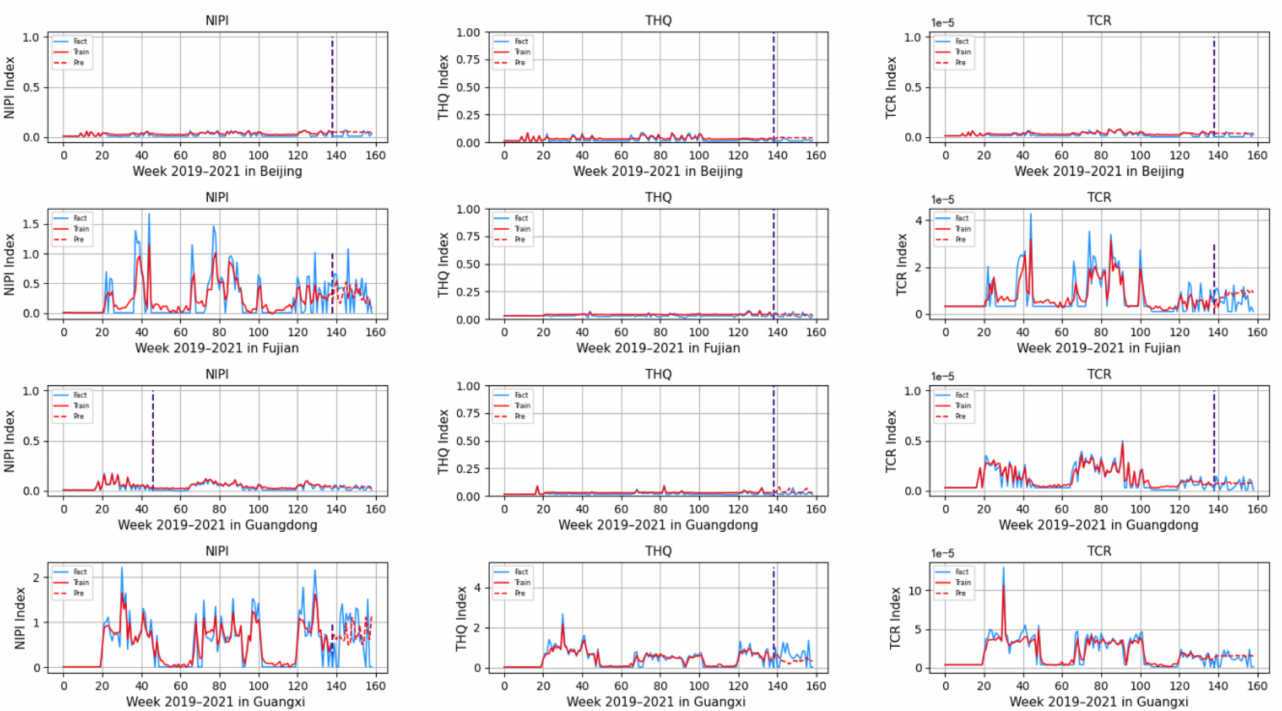
Figure 11. Predicted NIPI, THQ, and TCR indicators for Beijing, Fujian, Guangdong, and